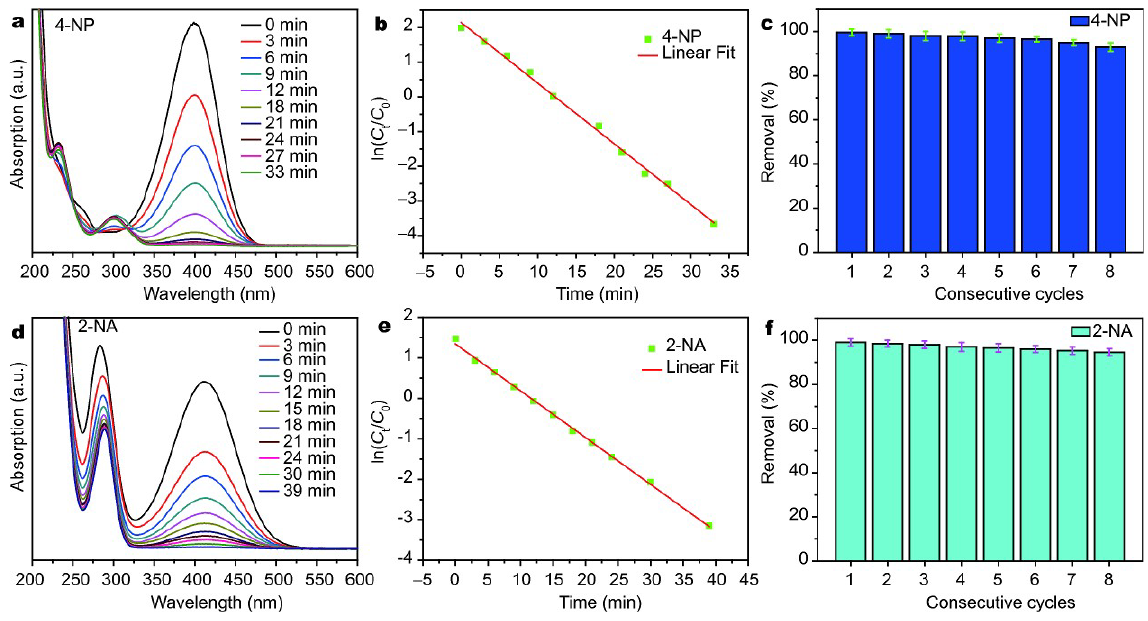
Figure 47. ( a , d ) Catalytic reduction of 4-NP or 2-NA with MXene@AuNPs20 composite. ( b , e ) The relationship between ln(C t /C o ) and the reduction time (t) of the nanocomposite catalyst. ( c , f ) The recyclable catalysis capacities of MXene@AuNPs20 composite for the reduction reaction of 4-NP or 2-NA by NaBH 4